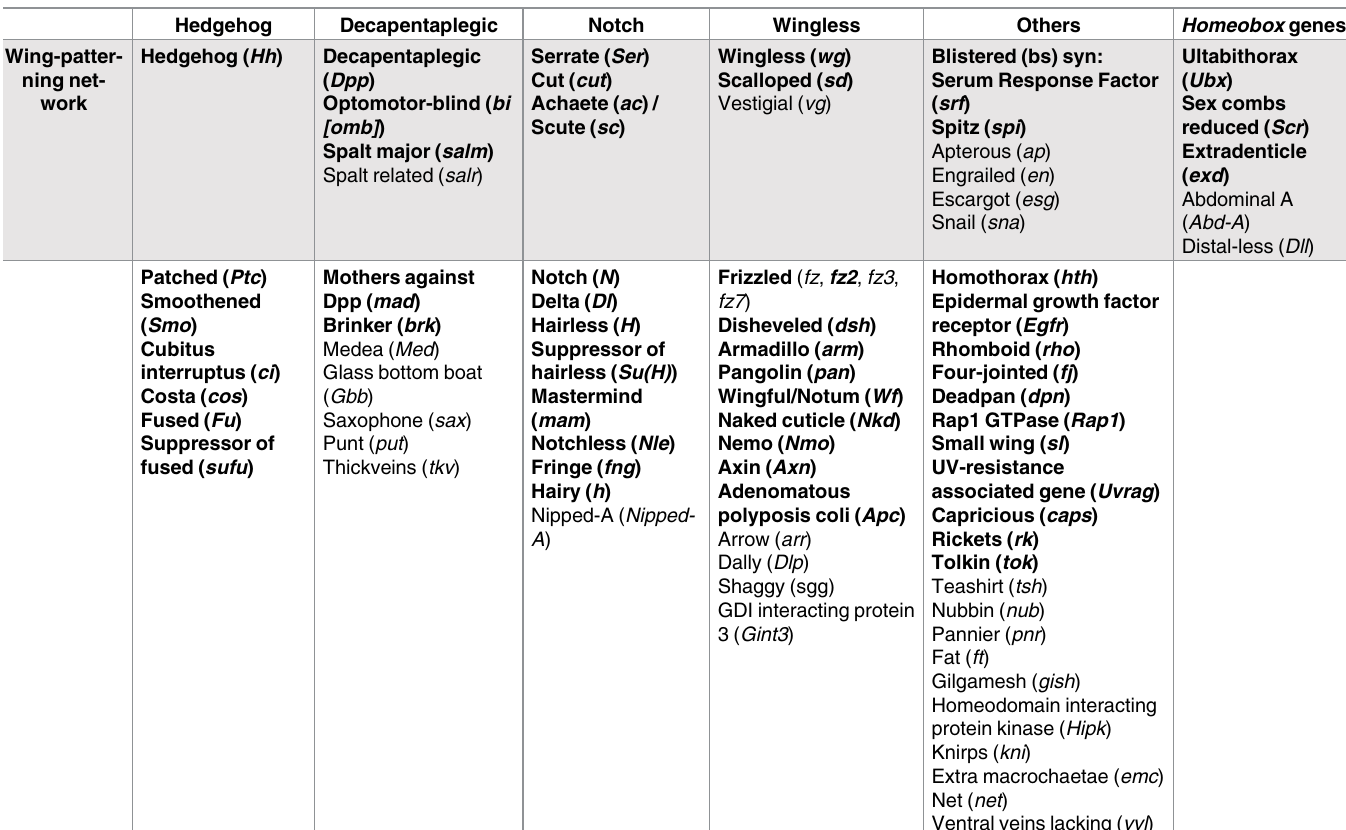
Table 3. Selection of genes responsible for wing development in insects. Genes of the four major signalingpathways and functionally related genes (“Others”) are arrangedin the accordingcolumns. Membersof the wing-patterning network [2, 57] known to be associated with a specific signalingpathway are shown in the grey row [5, 9, 58, 59, 67–72].Genes identified in the M . caerulatus transcriptome are shown by bold; while the correspondingamino acid sequencesand unigene IDs are given in S4 File and a description of primary genefunctions are in the S1 Table. Genes that could not be identified in the M . caerulatus transcriptome are shown in black